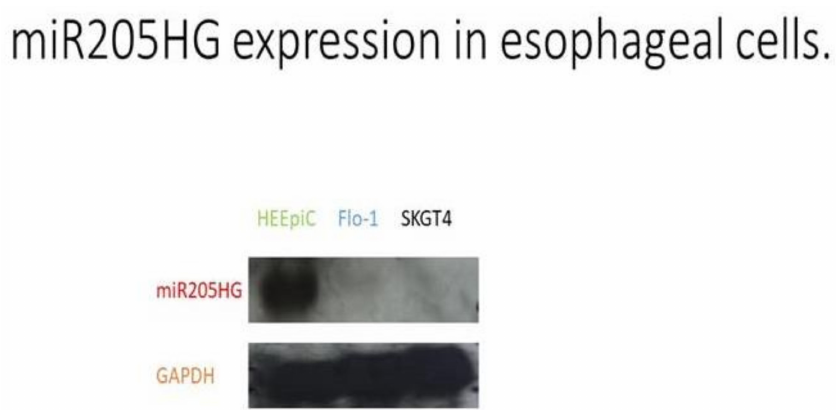
Figure 3. miR205HG expression assessed via Northern blotting. glyceraldehyde 3-phosphate dehydro- genase (GAPDH) serves as an internal control. HEEPiC: normal primary esophageal epithelial cells; SKGT4: EAC-derived cell line; Flo-1: EAC-derived cell line (full blots can be found in Supplementary